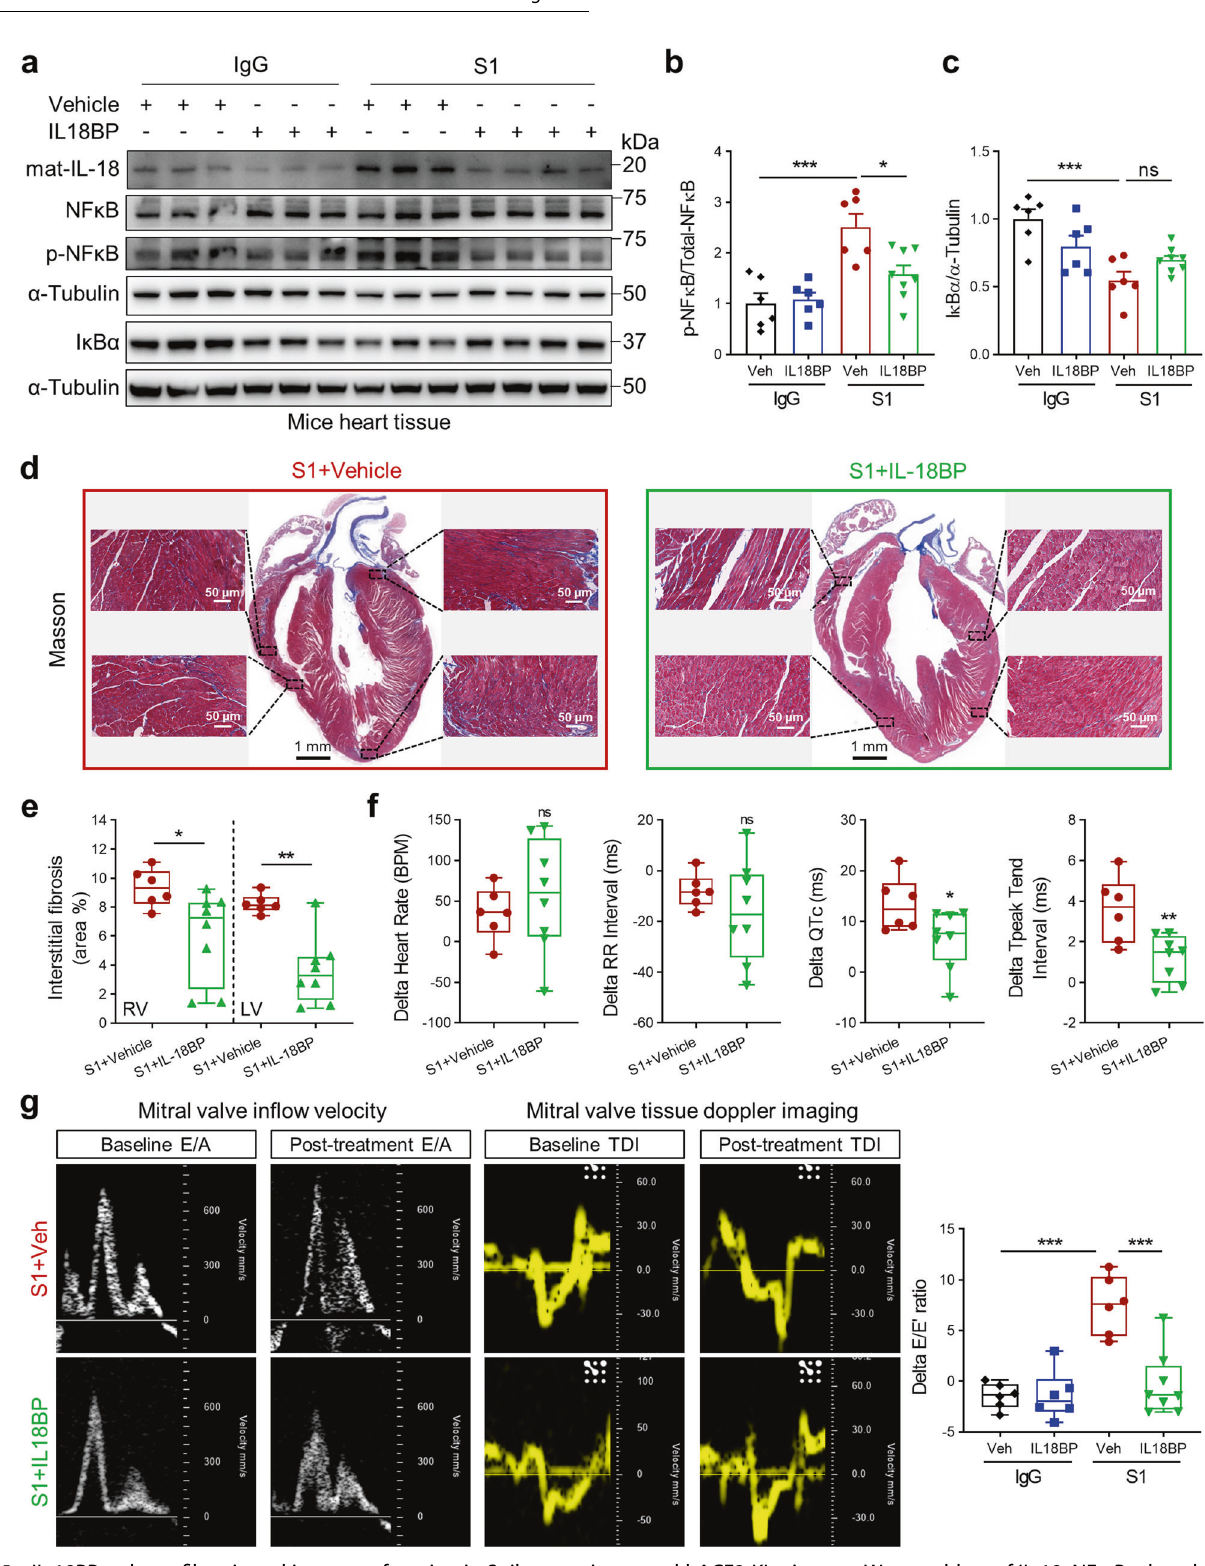
Fig. 5 IL-18BP reduces fi brosis and improves function in Spike protein-treated hACE2-KI mice. a – c Western blots of IL-18, NF- κ B, phospho-NF- κ B and I κ B α levels in heart tissues. Quantitative data shown in right panel ( b , c ) (1-way ANOVA test, N = 5 – 8). d , e Representative Masson Trichrome staining images of heart from IgG- versus S1 protein-treated mice with IL-18BP treatment. Fibrosis area percentage was reduced with IL-18BP injection (Student ’ s t -test, N = 6 – 8). f Heart rate, RR interval, QTc interval, Tp-Te interval were measured by electrocardiograms (ECG) in mice after S1 and IL-18BP exposure (Student ’ s t -test, N = 6 – 8). g IL-18BP exposure improved impaired diastolic function (1-way ANOVA test, N = 6 – 8). Values are mean ± SE. * p < 0.05, ** p < 0.01, *** p < 0.001